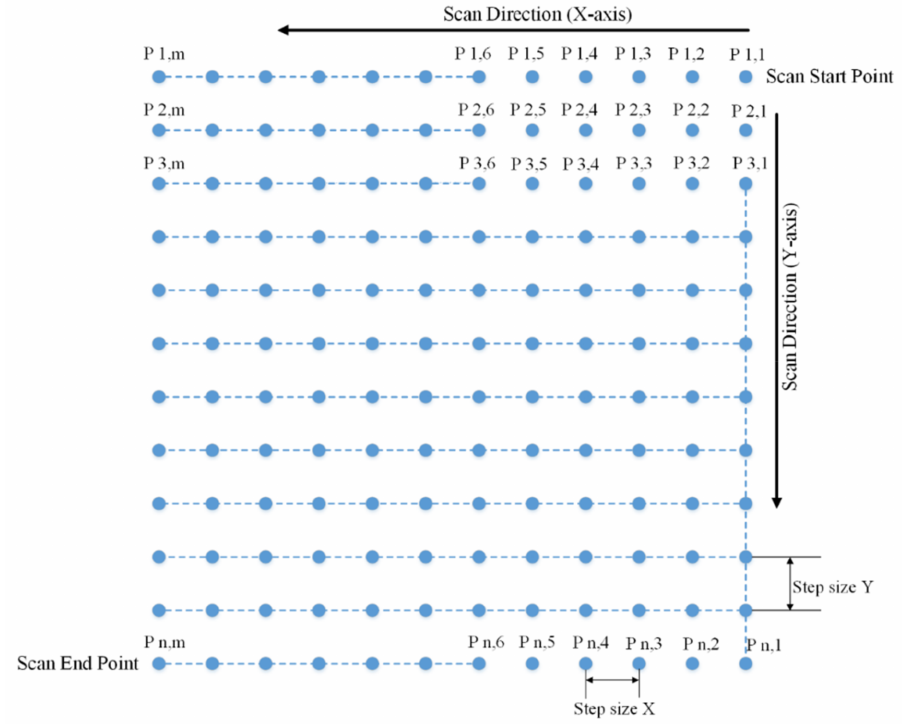
Figure 1. Acquisition of Raman spectral image by point-scan